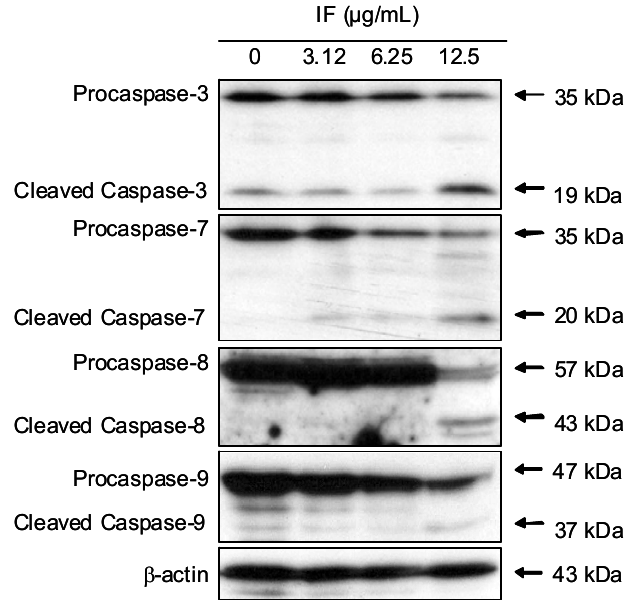
Figure 4. Effect of IF on the expression of caspase-3, -7, -8, and -9 in CNE cells at 72-h treatment. β -actin was used as the loading control. Results were representatives of three independent